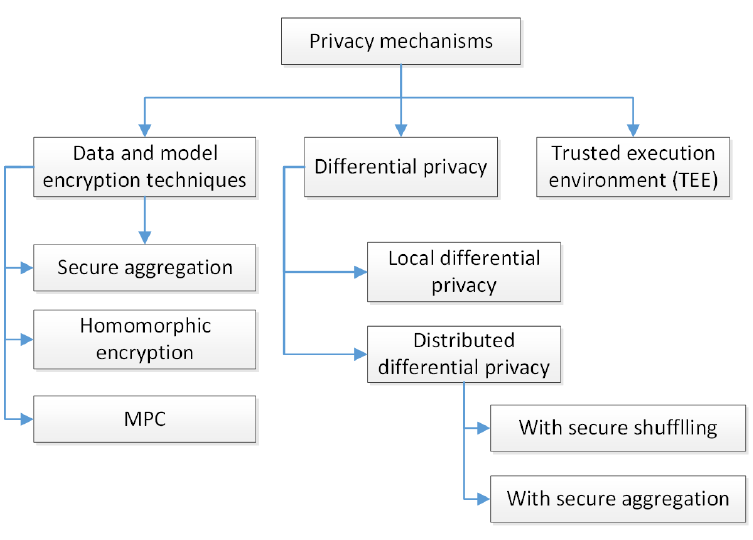
Figure 2. Overview of privacy-preserving mechanisms adopted for